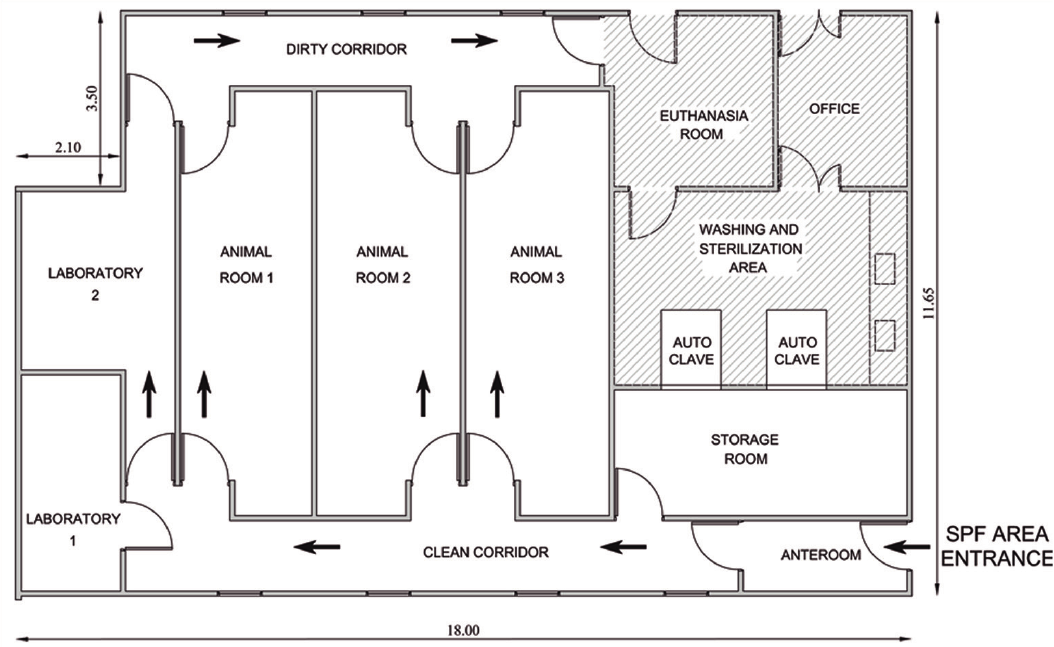
Figure 1 - Floor plan and workflow in the SPF facility. SPF area composed of three animal rooms: 1 = breeding, 2 = mouse colonies for transgenesis, 3 = experimentation; two laboratories: 1 = animal surgery and embryo manipulation, 2 = embryo micromanipulation; an anteroom, a storage room and two corridors (clean and dirty). Dirty materials go out by the dirty corridor only. Non-SPF area composed of a euthanasia room, a washing and sterilization area and an office (striped colored area). Black arrows indicate the workflow of personnel. Measures in